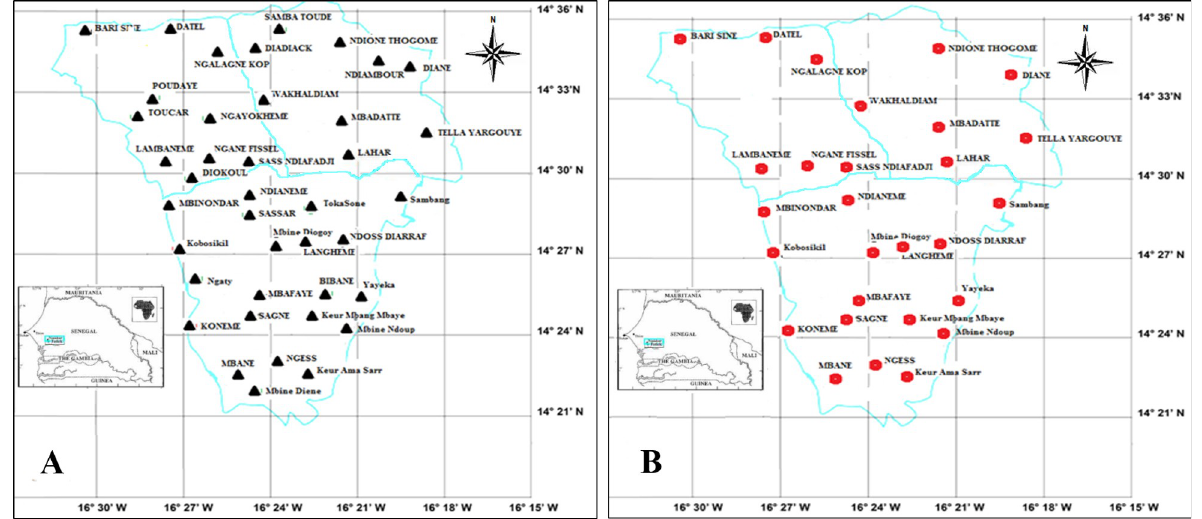
Fig 4. A. Spatial distribution of Ornithodoros sonrai ticks found in burrows of small mammals in the Niakhar district. B. Spatial distribution of B . crocidurae infection in the O . sonrai tick vector in the Niakhar district (source VITROME, IRD Dakar, Senegal).